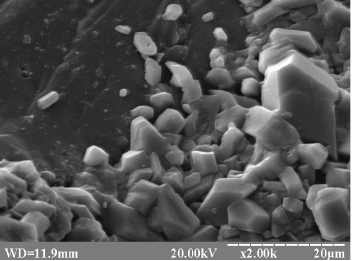
Fig. 2. Electron microscopic image of rhombic crystals of sulfur S 8 .